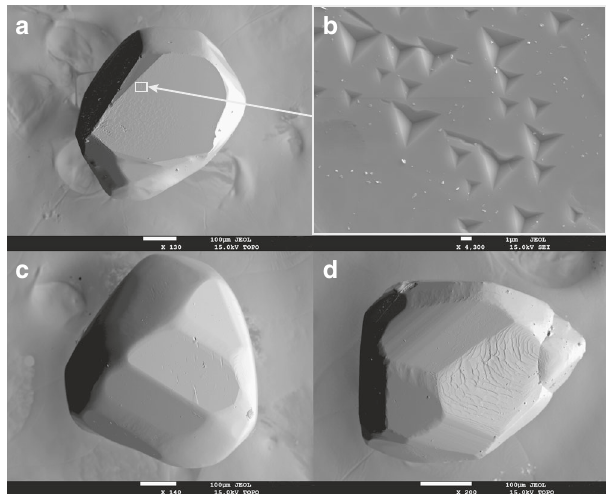
Fig. 1 Electron microprobe images of garnet inclusions showing diamond imposed cubo-octahedral morphology and syngenetic growth features. a Garnet inclusion V471. The surface of V471 b has diamond-like “ trigons ” that establish syngenetic growth of inclusion and host. c Inclusion V445. The top surface of V405 d records stepped features and the side faces show well-developed growth lines consistent with syngenetic growth with the host